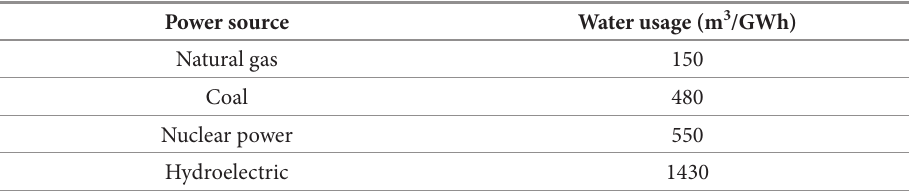
Table 5. Fresh water usage for different power